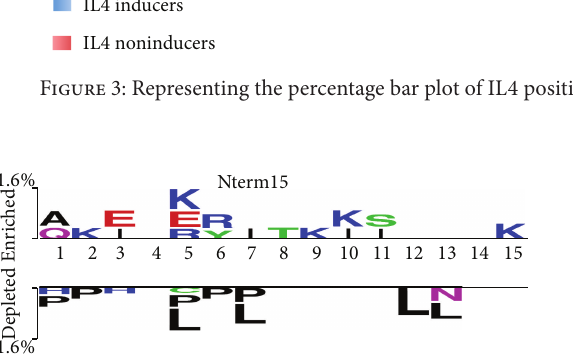
Figure 4: Two-sample logo displaying the positional conservation of amino acid for N15 residue among positive and negative